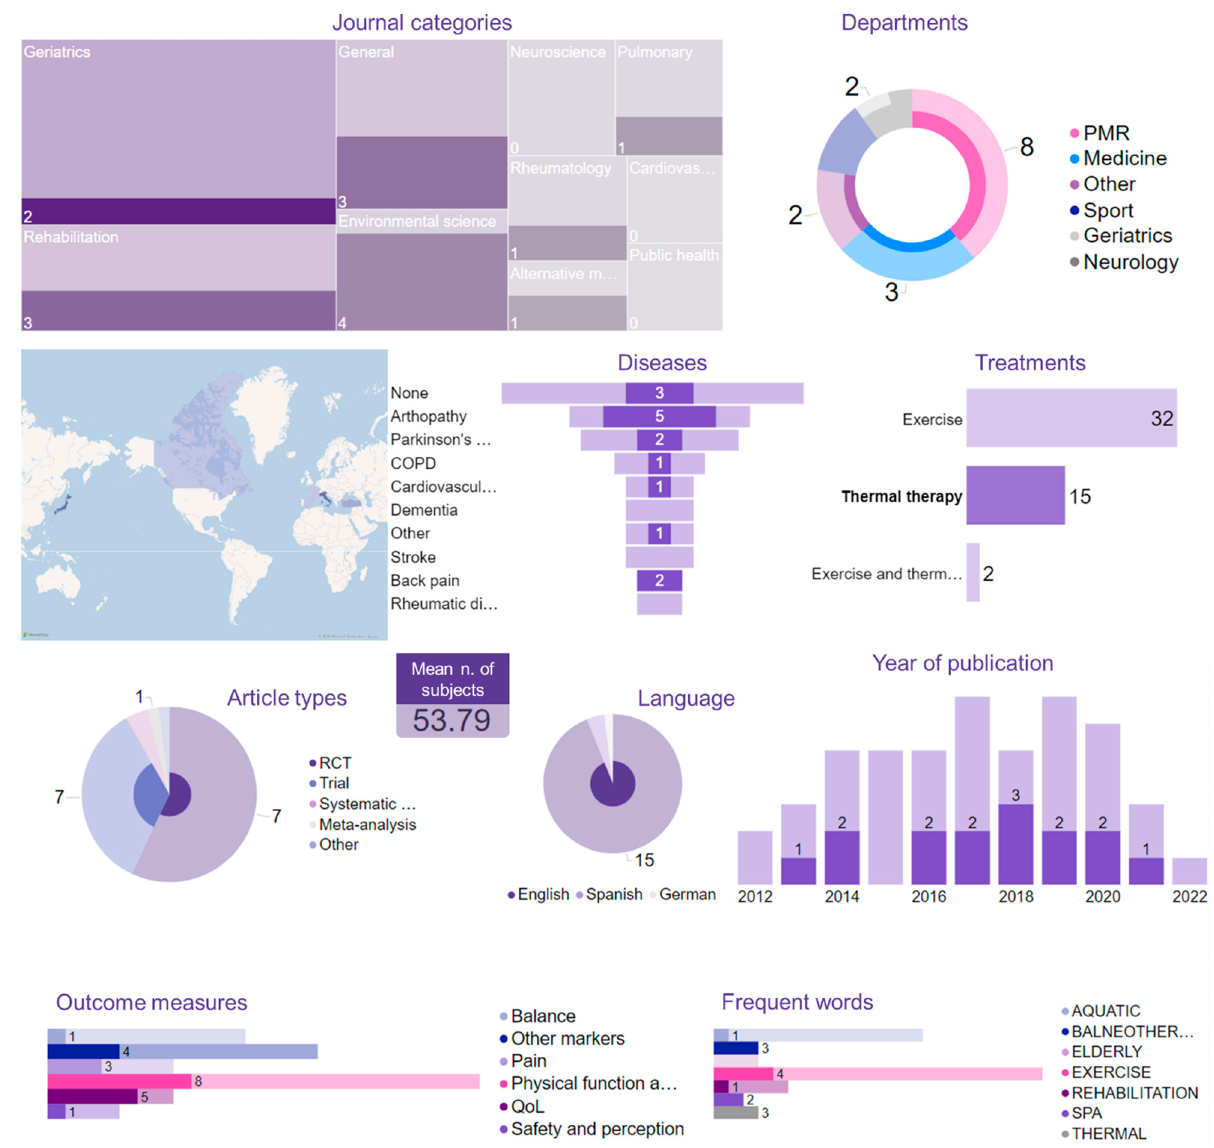
Figure 4. Results focused on the modality: “thermal therapy”. By filtering the modality of the variable, the relative results of the other variables are shown (dark colors in the graphs). The shading is the pale portion of the graph, including the results not related to the selected modality.